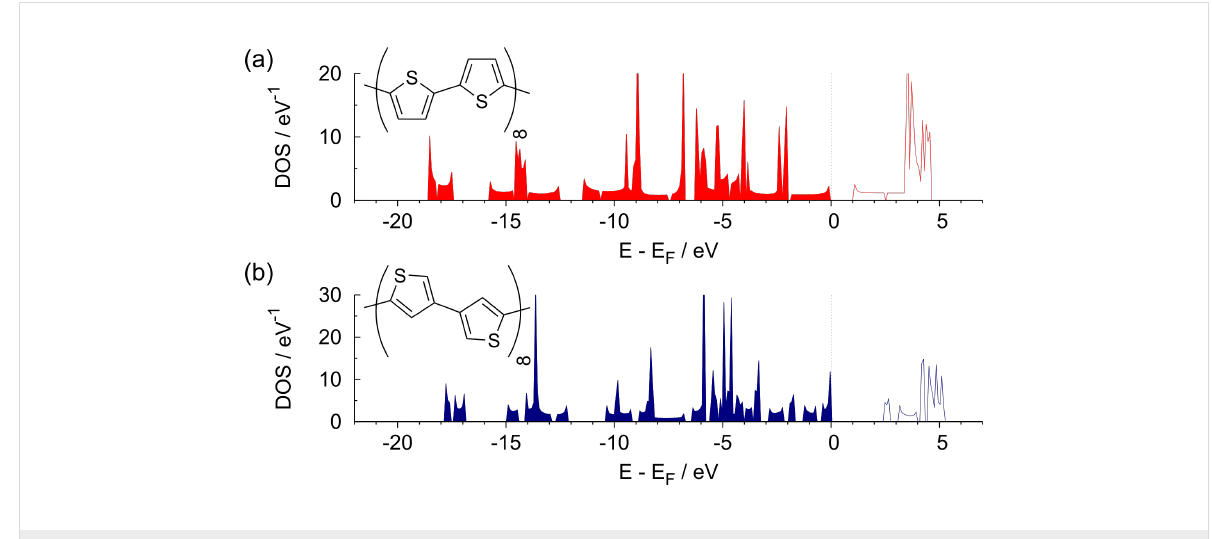
Figure 2: Structure and density of states for (a) PTp and (b) α , β -PTp.